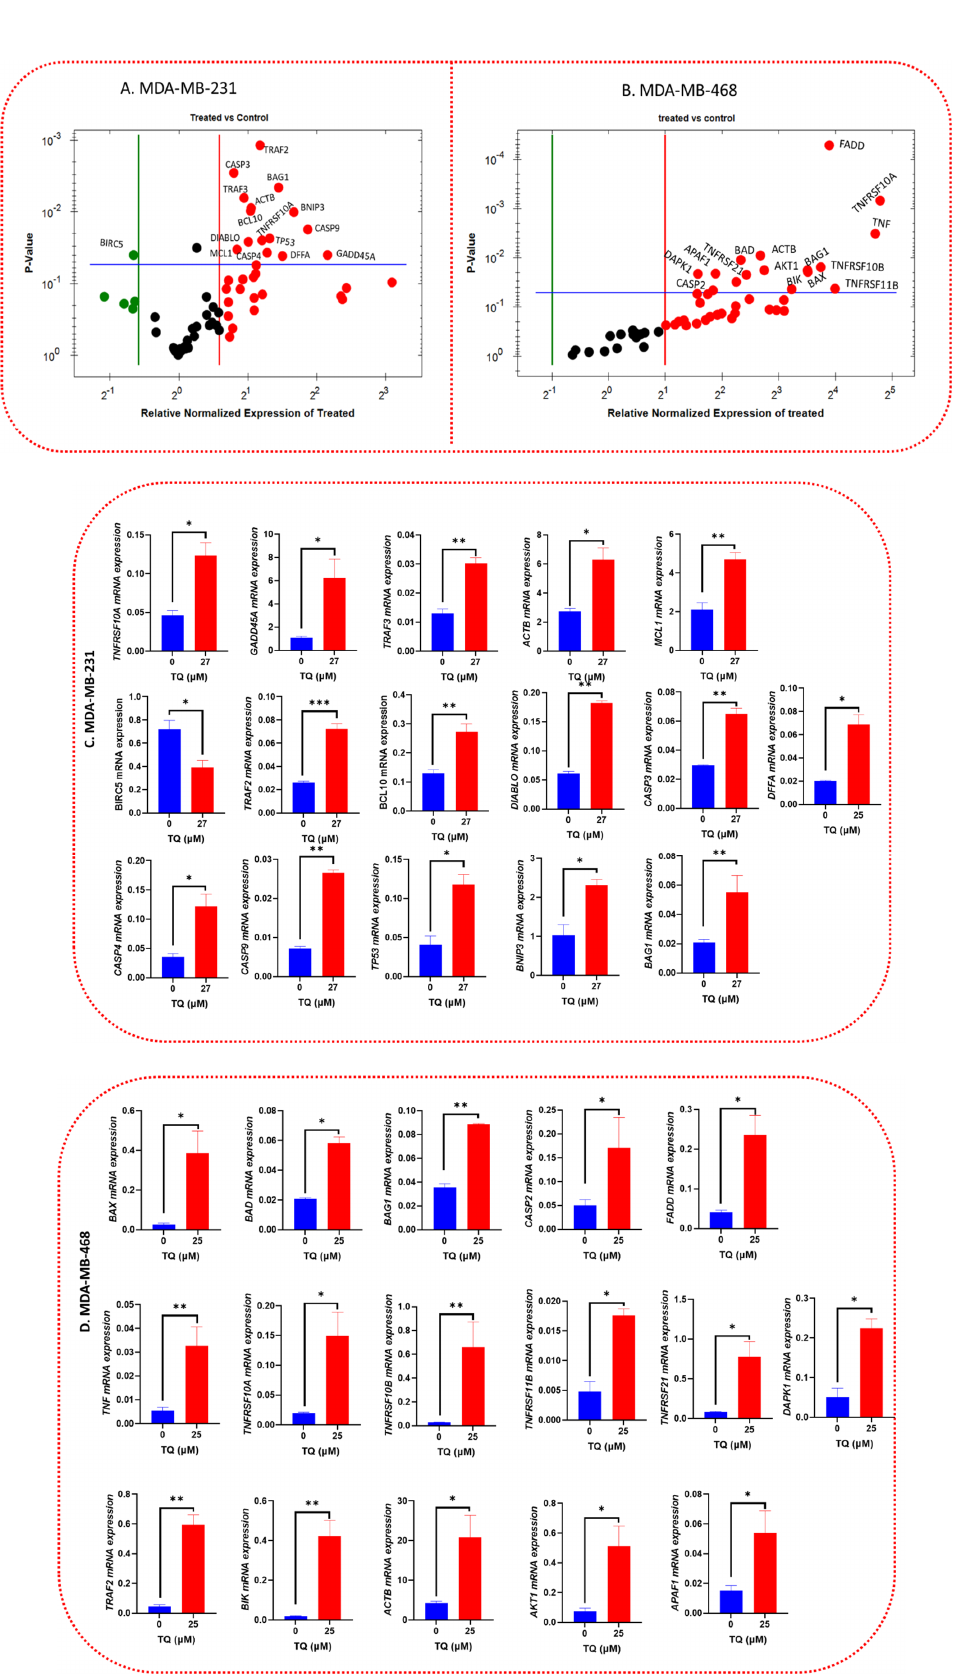
Figure 9. ( A , B ) TQ-altered apoptosis-related gene expression in MDA-MB-231 and MDA-MB-468 TNBC cells. After a 24 h treatment period with 27 µM µ in MDA-MB-231 cells ( A ) and 25 µM in MDA-MB-468 cells ( B ), a volcano plot was used to categorize and display increased(red), repressed